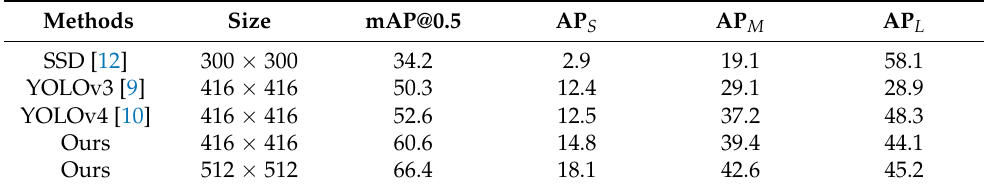
Table 2. mAP (%) obtained by several state-of-the-art methods.